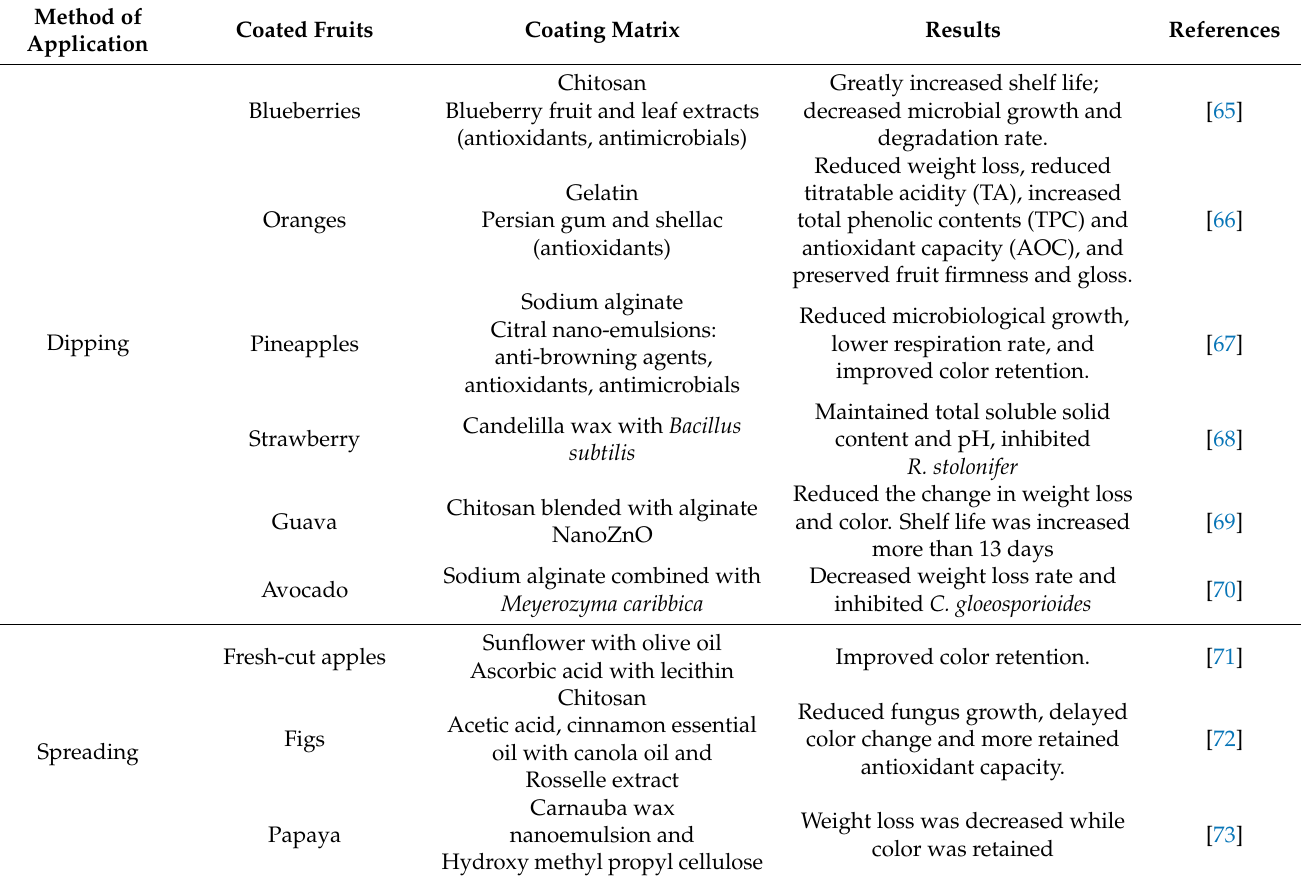
Table 2. Edible coatings applied to